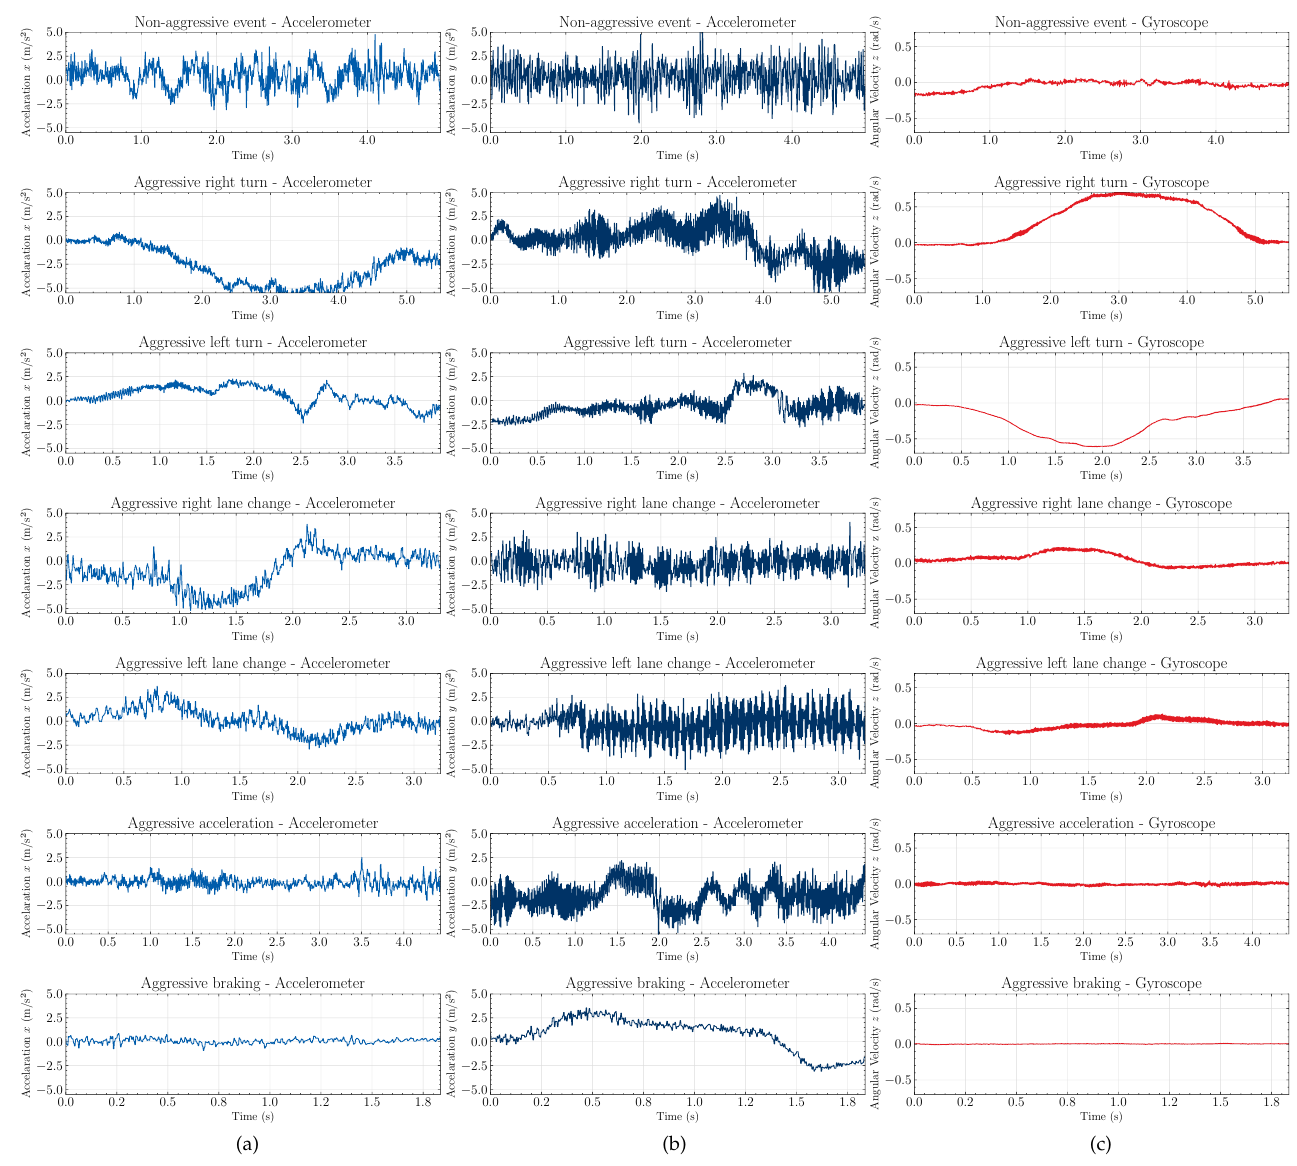
Figure 4. Raw data of linear acceleration in the x , first column ( a ), and y , second column ( b ), direction and angular velocity in z , third column ( c ), for non-aggressive events (first row), aggressive right and left turn (second and third rows), aggressive left and right lane change (fourth and fifth rows), aggressive braking (sixth row), and aggressive acceleration (seventh row),